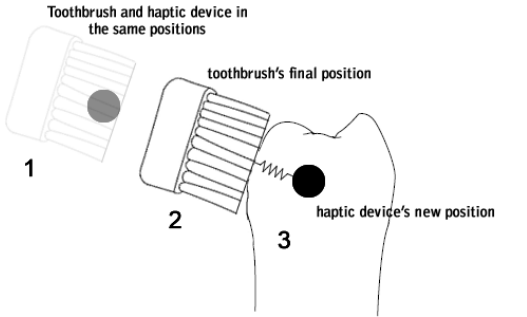
Fig. 7. Graphical representation of Haptic Rendering